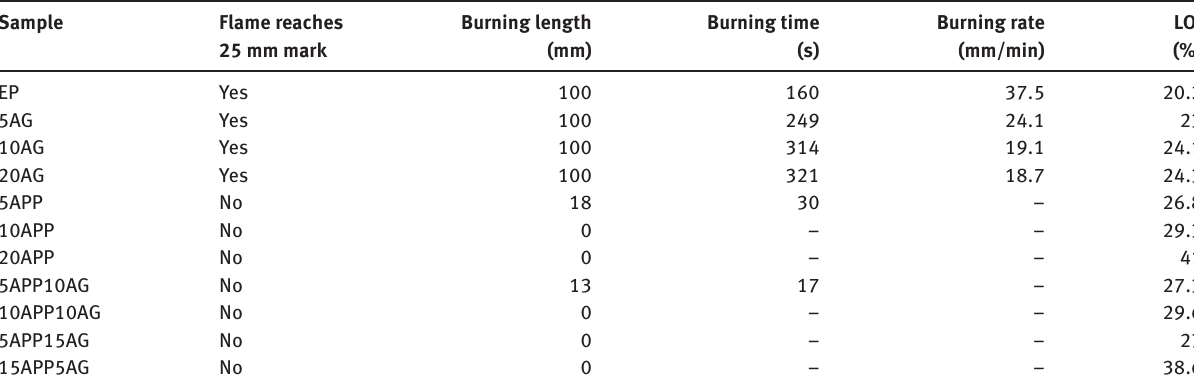
Table 1: Characterization of flame-retardancy of the epoxy composites. Sample